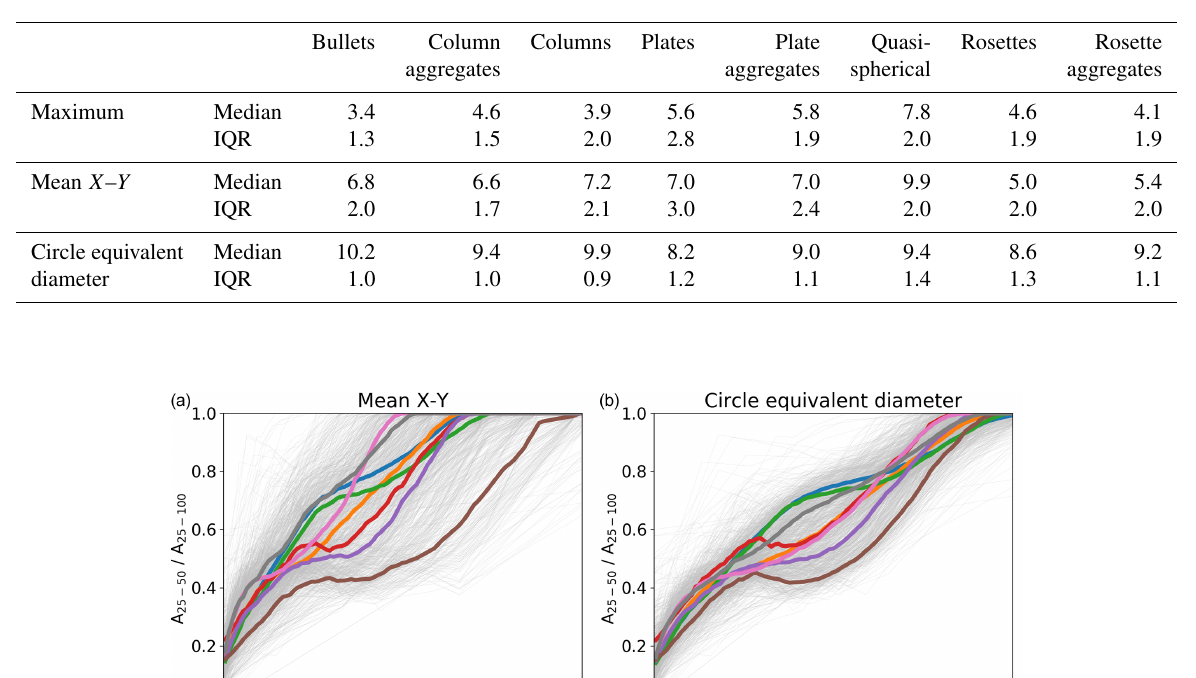
Table 1. Median and interquartile range (IQR) normalised dimensionless distance from the object plane ( Z d ) where particles are no longer visible for different habits; this is equivalent to c in Eq. (1).